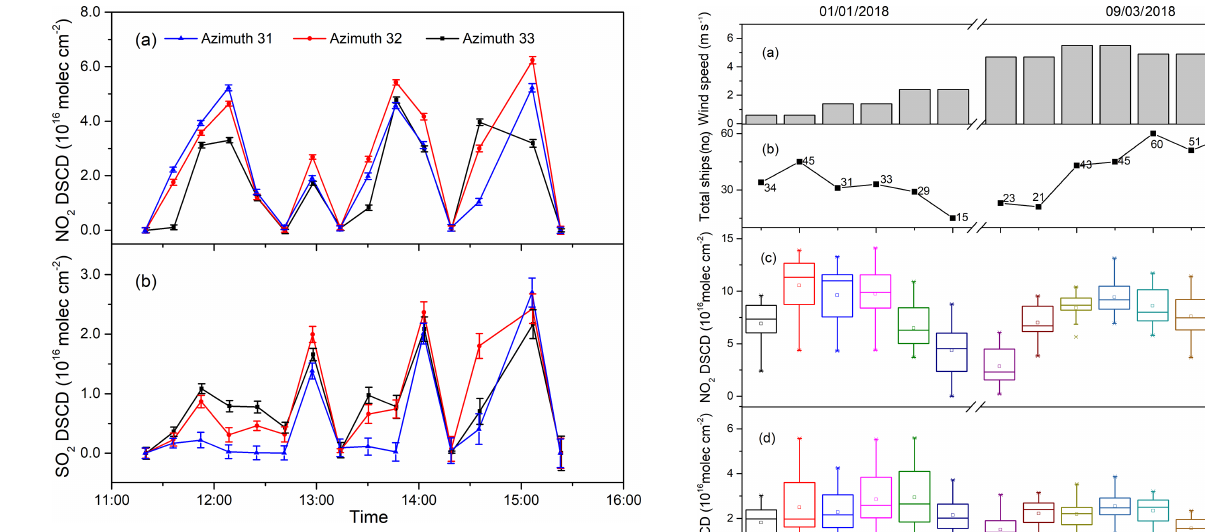
Figure 6. Time series of DSCDs of (a) NO 2 and (b) SO 2 measured at a 4 ◦ elevation angle at three azimuths on 28 August 2017.